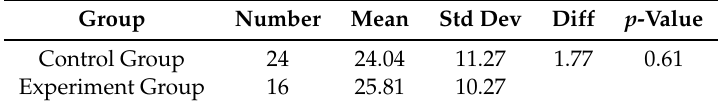
Table 1. The t -test analysis result of a pre-test in the control and experiment group. Group